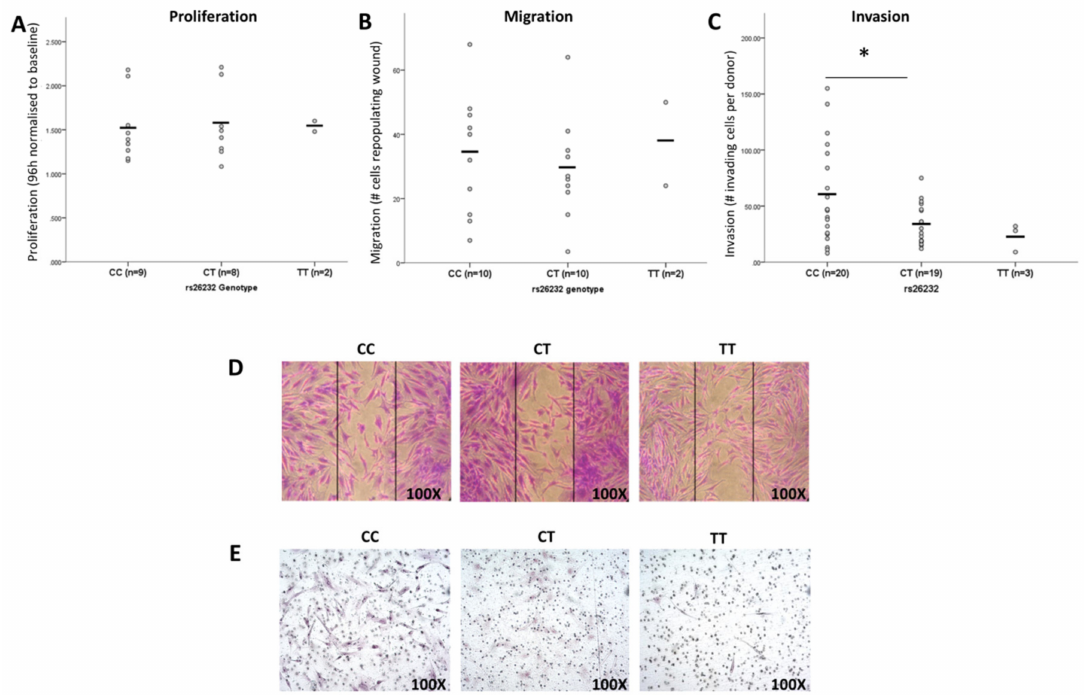
Figure 1. The rs26232 genotype is associated with RASF invasiveness. ( A ) Proliferation rates of RASFs are not associated with rs26232 genotype ( p = 0.980). ( B ) The capacity for cells to migrate was not associated with genotype ( p = 0.783). ( C ) RASF of the CC genotype are more invasive than CT ( p = 0.020). Representative images of RASF in vitro ( D ) migration and ( E ) invasive assays of rs26232 genotypes. Each circle represents the average of an individual donor. Horizontal black bars represent the cohort mean. Statistical significance: * p <